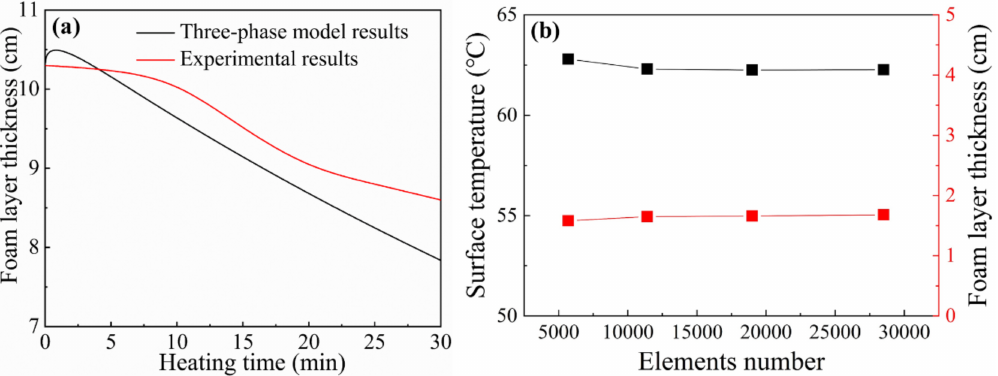
Figure 2. ( a ) Comparison between the numerical model and the experimental results [35] and ( b ) mesh independence verification.